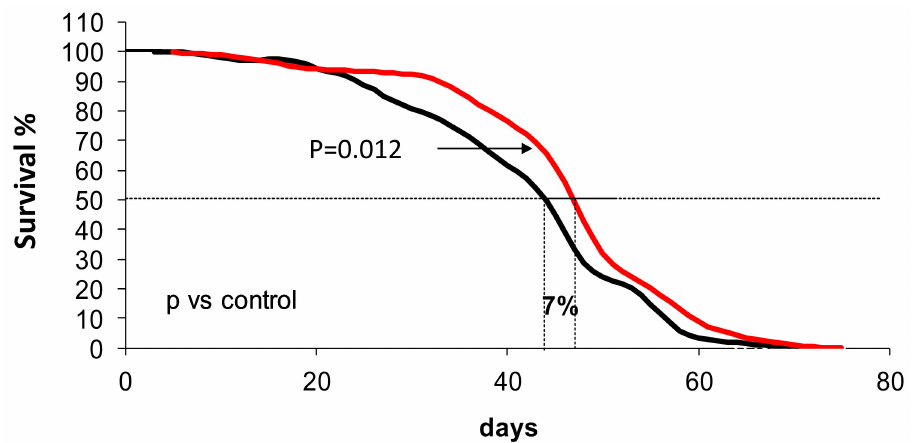
Figure 4. Survival curve of flies treated with or without red wine. Approximately 300 male flies from each group were used in the experiments. The red line corresponds to red wine treated group and black to the control group. The statistics were performed with the Kaplan–Meier test and the significance is expressed as p < 0.05 compared to the